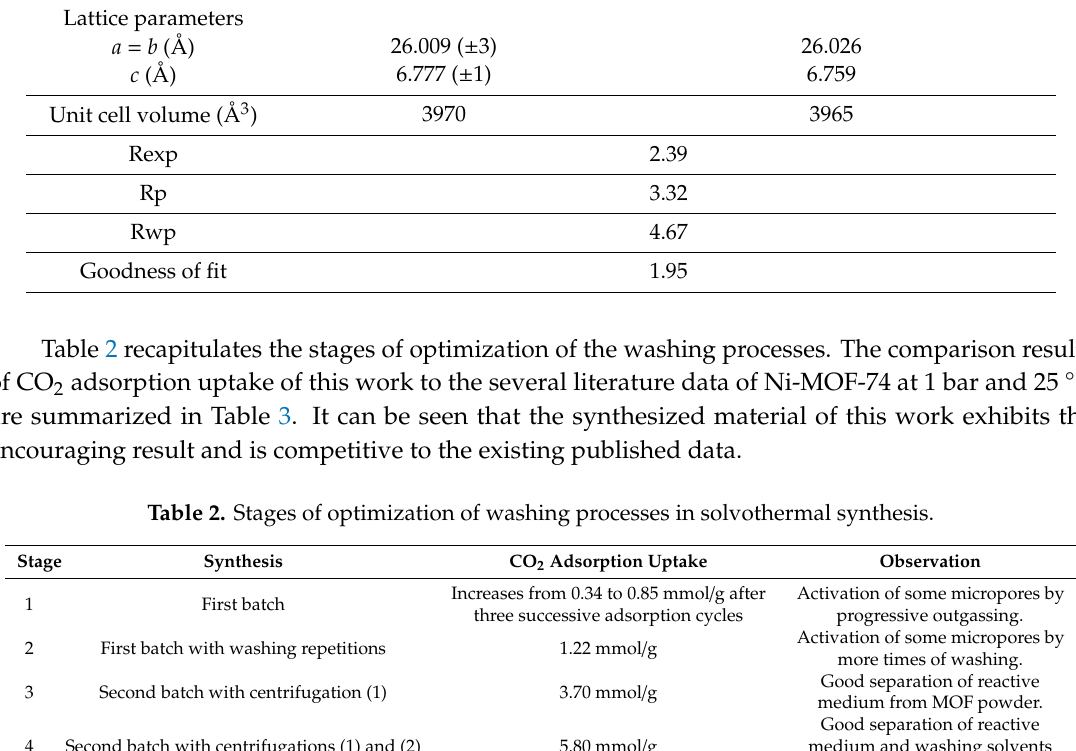
Table 3. Comparison results of CO 2 adsorption uptake of Ni-MOF-74 at 1 bar and 25 °C with literature data.